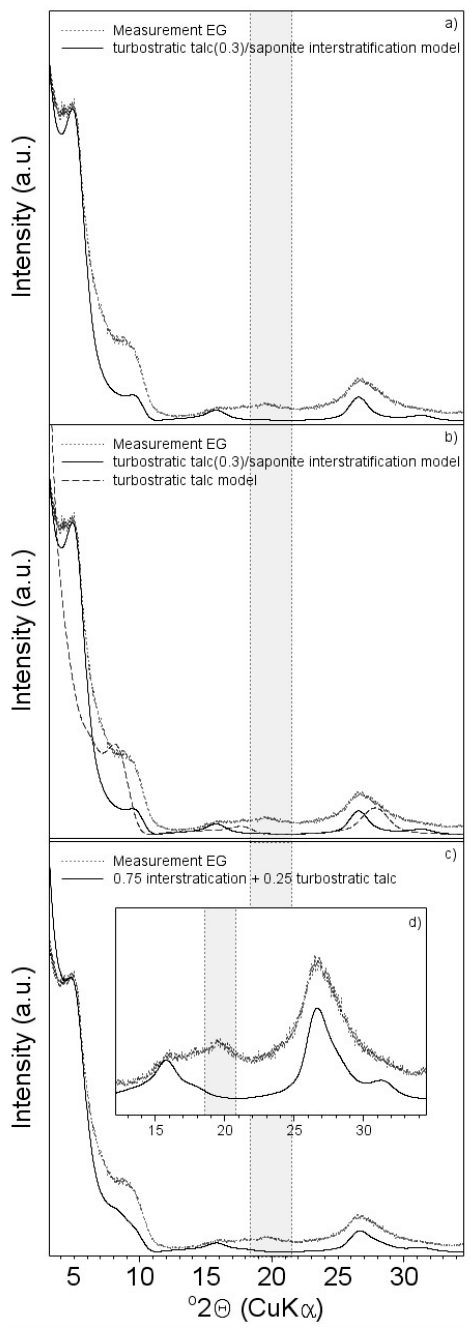
Figure 6. EG-treated XRD pattern of the oriented clay fraction sample in comparison to the modeled pattern by NEWMOD: ( a ) turbostratic talc (0.3)/saponite interstratification model; ( b ) turbostratic talc(0.3)/saponite interstratification model + turbostratic talc model; ( c ) mixture of interstratification (0.75) model + turbostratic talc model; and ( d ) enlarged view of (c).